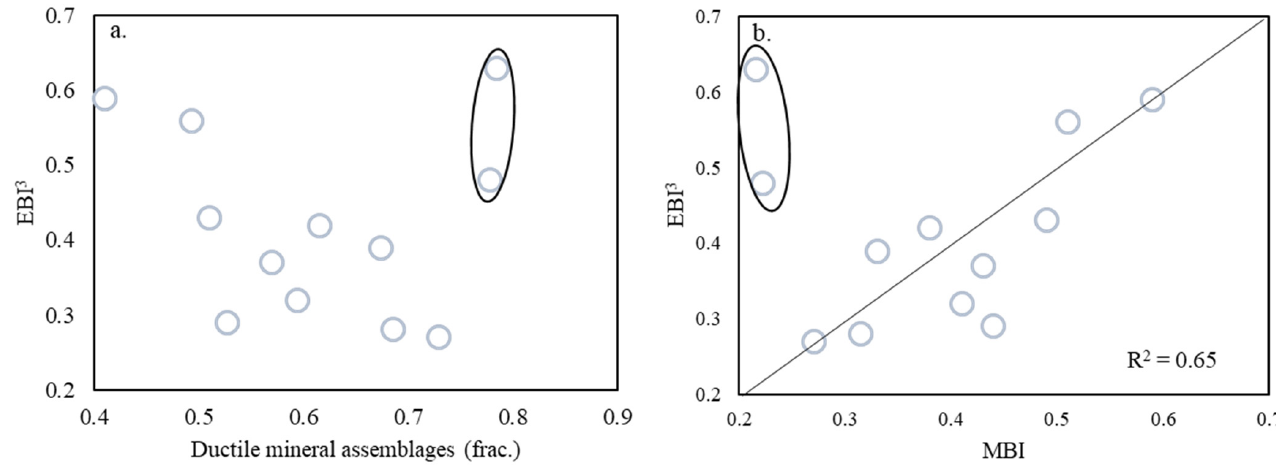
Figure 10. Correlation between the elastic properties-based brittleness indices (EBI 3 ) versus ductile mineral assemblages ( a ) and mineralogy-based brittleness indices ( b ). A strong correlation is observed between elastic properties and mineralogy within the studied